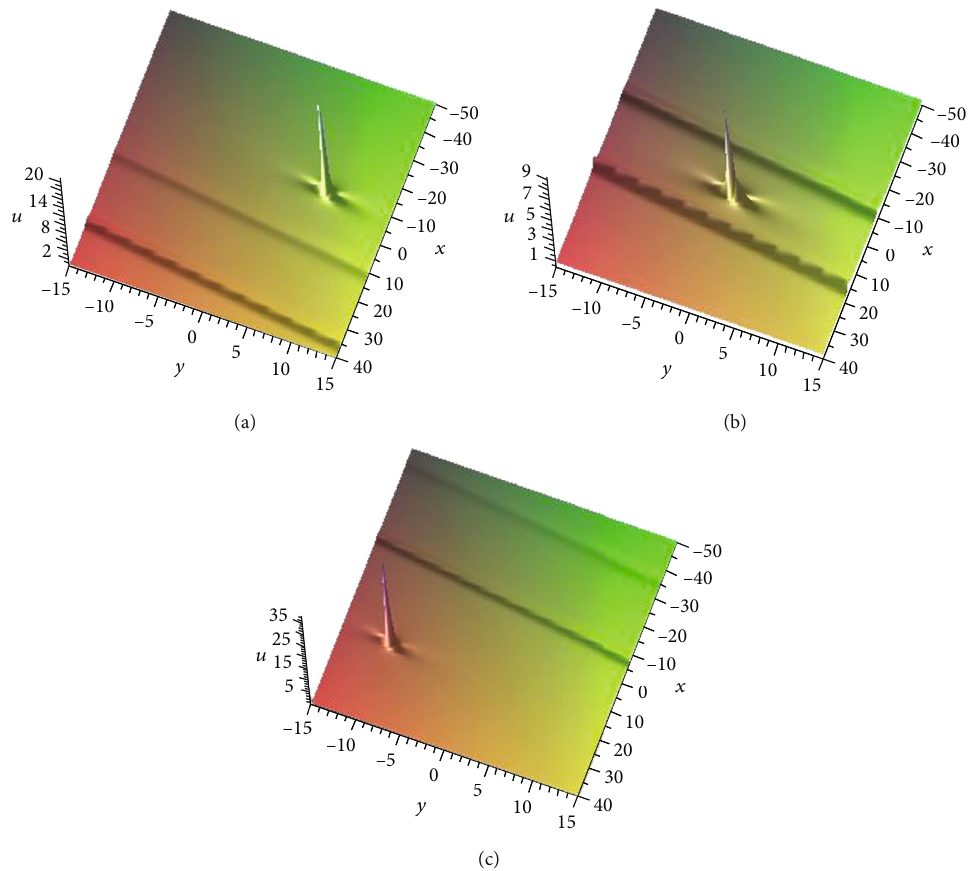
Figure 11: Propagation of hybrid solution composed of a soliton molecule and a lump at di ff erent times: (a) n = − 20 , (b) n = 0 , and (c) n = 25